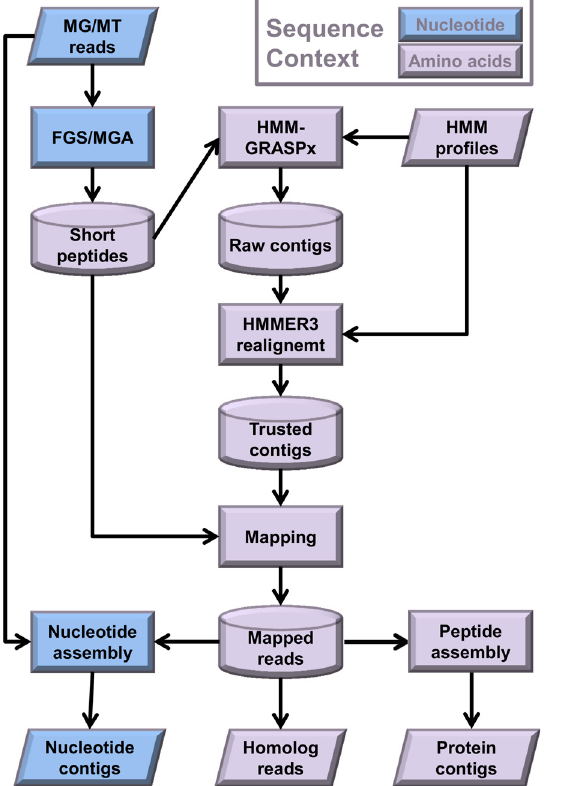
Fig 1. The HMM-GRASPx pipeline for homology search and gene-centric assembly. Blue shading of the objects indicates that the corresponding data or operation is in nucleotide space, while purple shading indicates amino-acid